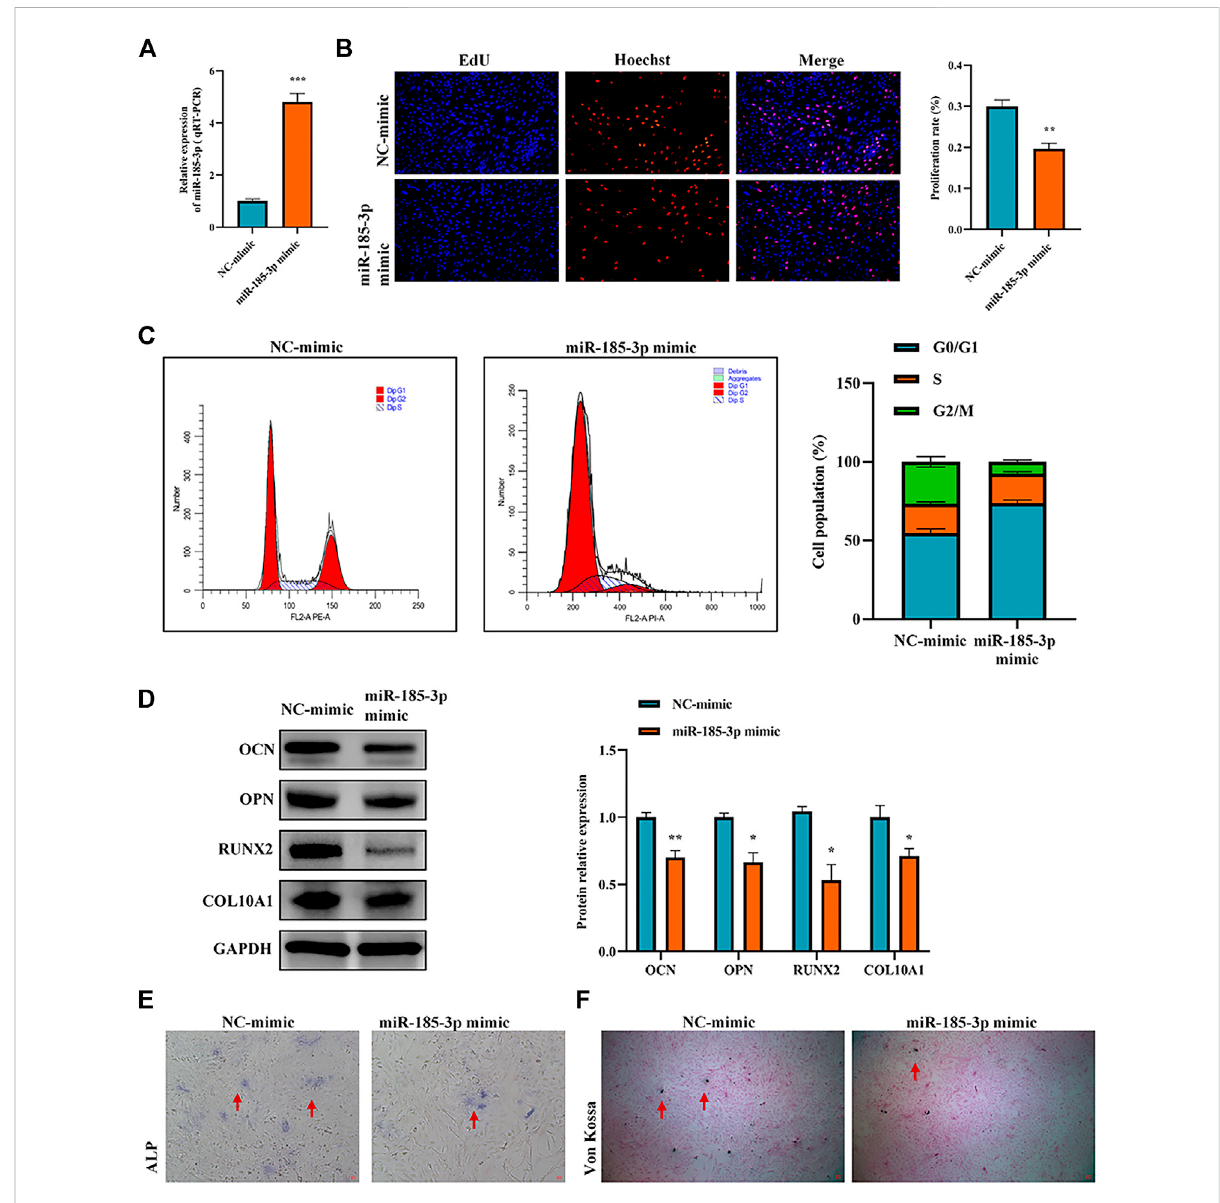
FIGURE 4 Upregulation of miR-185-3p suppresses chondrocytes growth and proliferation and cartilage osteogenesis. (A) The RNA levels of miR-185-3p in human chondrocytes transfected with miR-185-3p mimics were measured by RT-qPCR. (B) The effect of overexpression of miR-185-3p on chondrocyte proliferation was detected by Edu assays. (C) The effect of overexpression of miR-185-3p on chondrocyte cell cycle was detected by fl ow cytometry. (D) The protein expressions of OCN, OPN, RUNX2 and collagen type X were measured in miR-185-3p overexpressed chondrocytes. (E) ALP activity was measured in miR-185-3p overexpressed chondrocytes. (F) Von Kossa staining demonstrated changes in mineralization in miR-185-3p overexpressed chondrocytes. P > 0.05; *, p < 0.05; **, p < 0.01; ***, p < 0.001; ****, p <